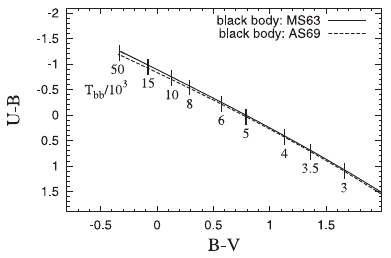
Fig. 1. Comparison of the blackbody color indices calcu- lated by Eq. (5) (the solid line, Matthews & Sandage 1963) and Eq. (6) (the dashed line, Aˇzusie- nis & Straiˇzys